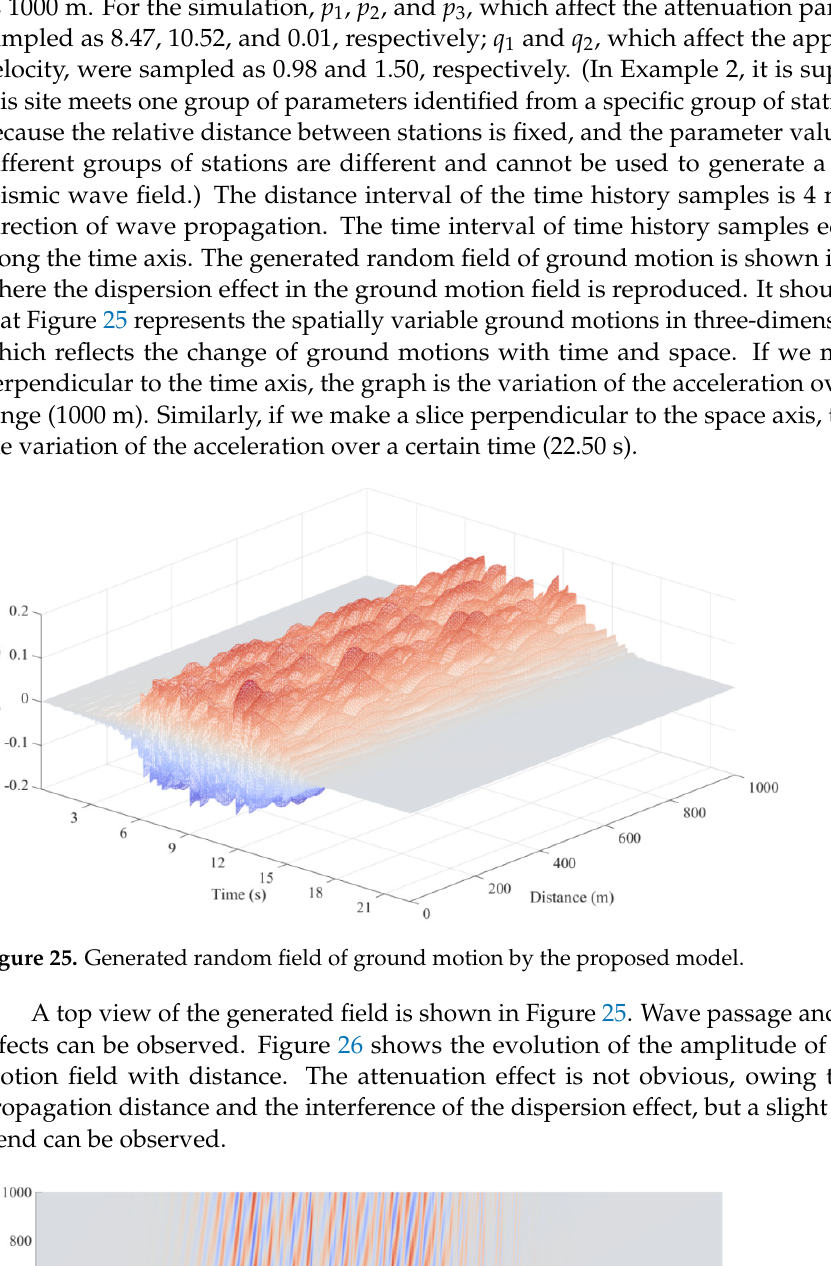
( b ) Figure 24. Accelerations and displacements in sample 3: ( a ) simulated accelerations and ( b ) its cor- responding displacements. 3.5.2. Example 2 A continuous random field of ground motion was generated to illustrate the disper-